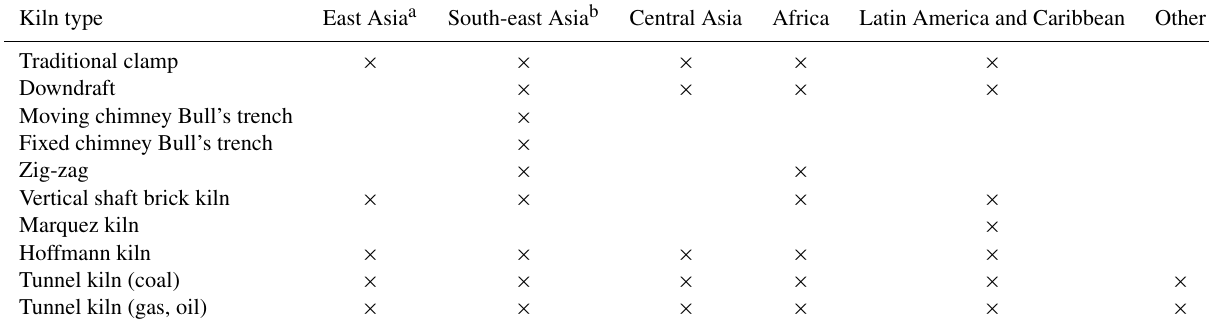
Table 4. Brick sector technology structure assumed in GAINS for different regions. Kiln type East Asia a South-east Asia b Central Asia Africa Latin America and Caribbean Other Traditional clamp